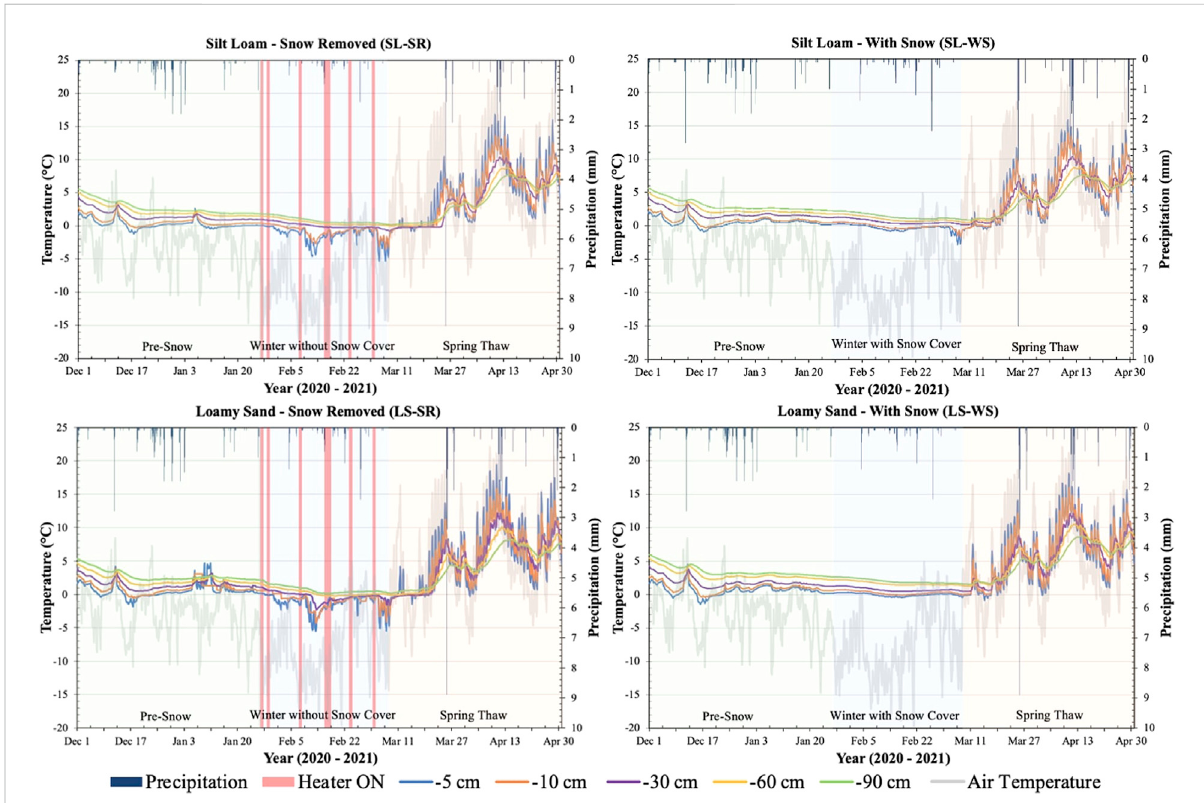
FIGURE 1 Soil temperature (primary y -axis) measured at -5, -10, -30, -60, and -90 cm depths in four lysimeters between 1 December 2020, and 30 April 2021. Soil temperature is plotted with air temperature (primary y -axis) and precipitation (secondary y -axis) recorded from the Environment Canada Elora Weather Station. The graphs for SL-SR and LS-SR also show when the heaters were turned on and off during the winter to melt snow on the lysimetersurface(redbarsonwinterwithoutsnowcoverphase).Thegraphsaredividedintothreephases,pre-snow,winterwith/withoutsnow, and spring-thaw, to determine the patterns of change during each of the experimental